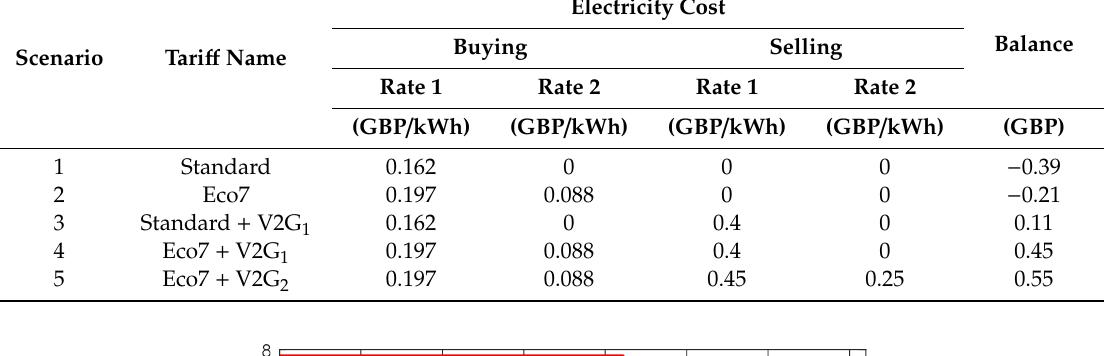
Table 6. DP (Dynamic Programming) algorithm tested for multiple scenarios.